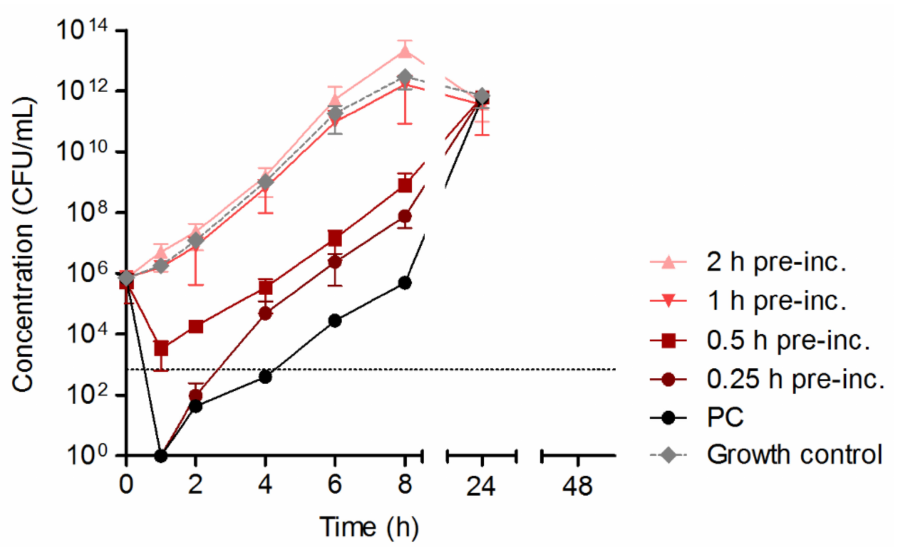
Figure 3. Time–kill curves of the 16-fold MIC of HY-133 applied against S. aureus strain ATCC 29213 subsequent to bacteria-free HY-133 pre-incubation (exposure times of 0.25 h to 2 h). Plot shows mean values for log 10 of the numbers of CFU/mL versus time. The threshold (dotted line) implicates the ≥ 3 − log 10 decrease in CFU/mL. Time–kill curves were performed in tripli- cate (mean ± standard deviation). Cultures of S. aureus strain ATCC 29213 (i) with freshly applied HY-133 and (ii) without HY-133 were included as positive and growth control, respectively.